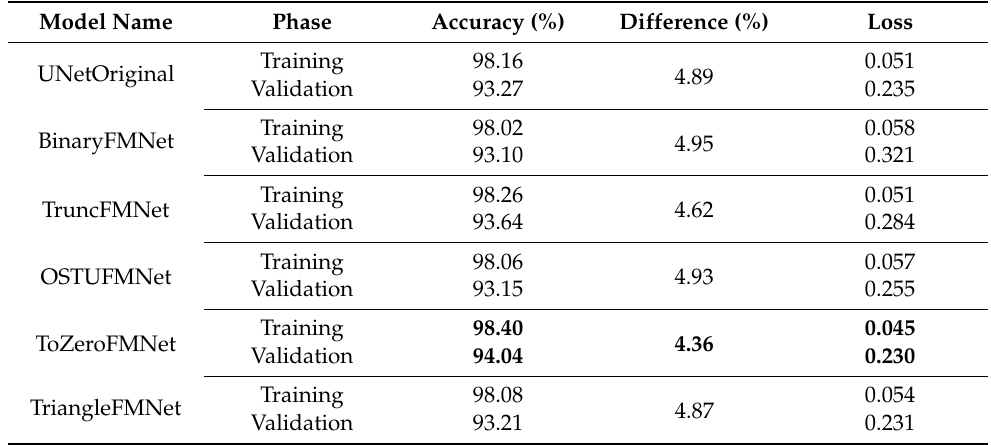
Table 1. Comparison of training and verification results between six models. N.B. the bold text indicates the best